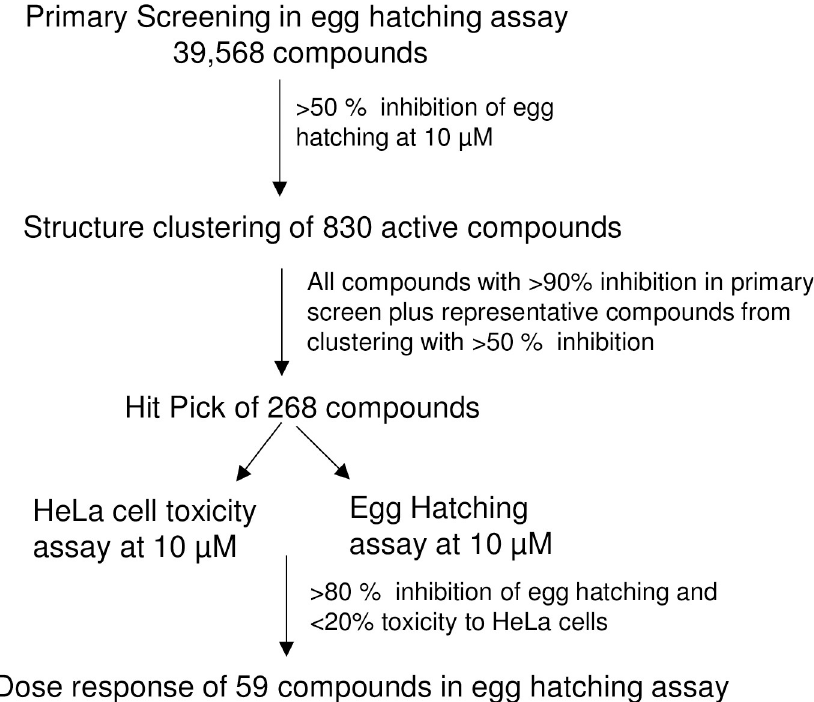
Fig 3. Cluster structures are followed by the number of members in parentheses. R groups are those positions most frequently substituted but all open valences or hydrogens sites may also be substituted.